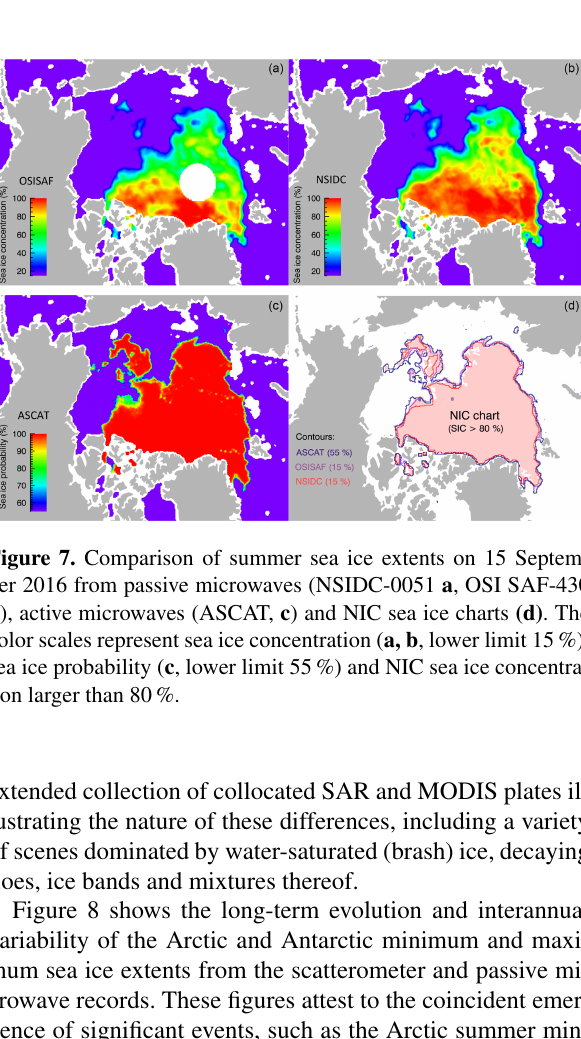
Figure 6. Comparison of ERS, QuikSCAT, ASCAT and passive microwave (OSI SAF-409a and NSIDC-0051) sea ice extents over 2000 (a) and 2008 (b) .